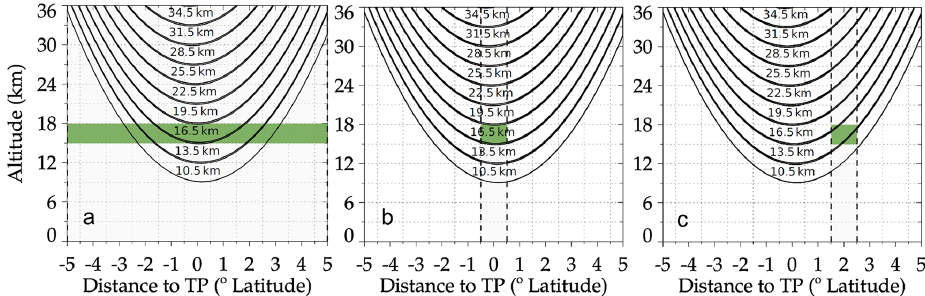
Figure 7. Schematics of the lines-of-sight of SCIAMACHY limb geometry. The current limb retrieval assumes an infinite, homogeneous aerosol layer centred at the TH (green layer in panel a ). If aerosols are localised (b) , extinction is underestimated; if the plume is additionally not centred at the tangent point TP (c) , both extinction and plume altitude are underestimated. See the text for further details.